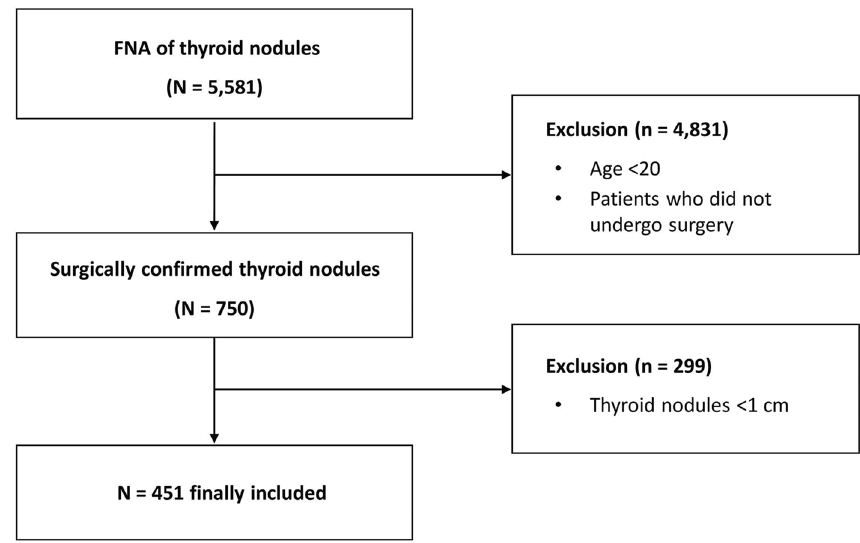
Figure 3. Flow diagram of study participants. FNA, fine-needle